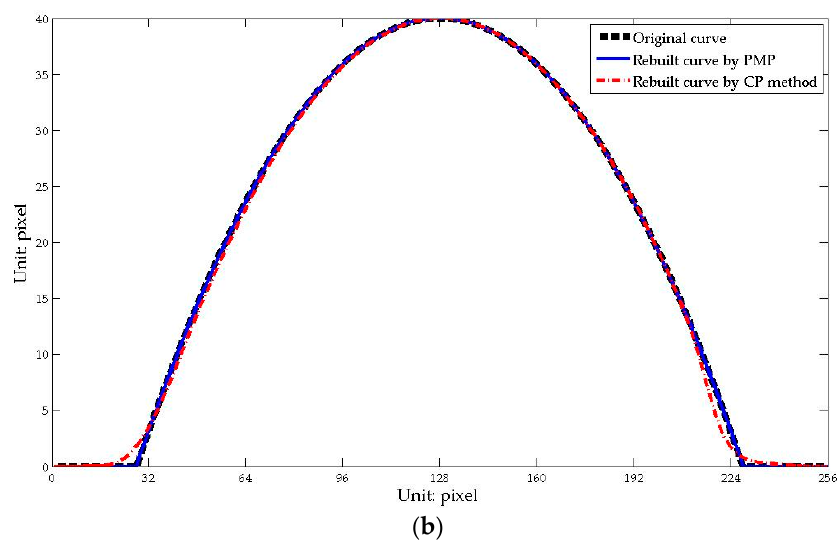
Figure 10. Simulation using an artificial upside-down bowl. ( a ) The original profile; ( b ) contour curves comparison of the two reconstructions against the original.